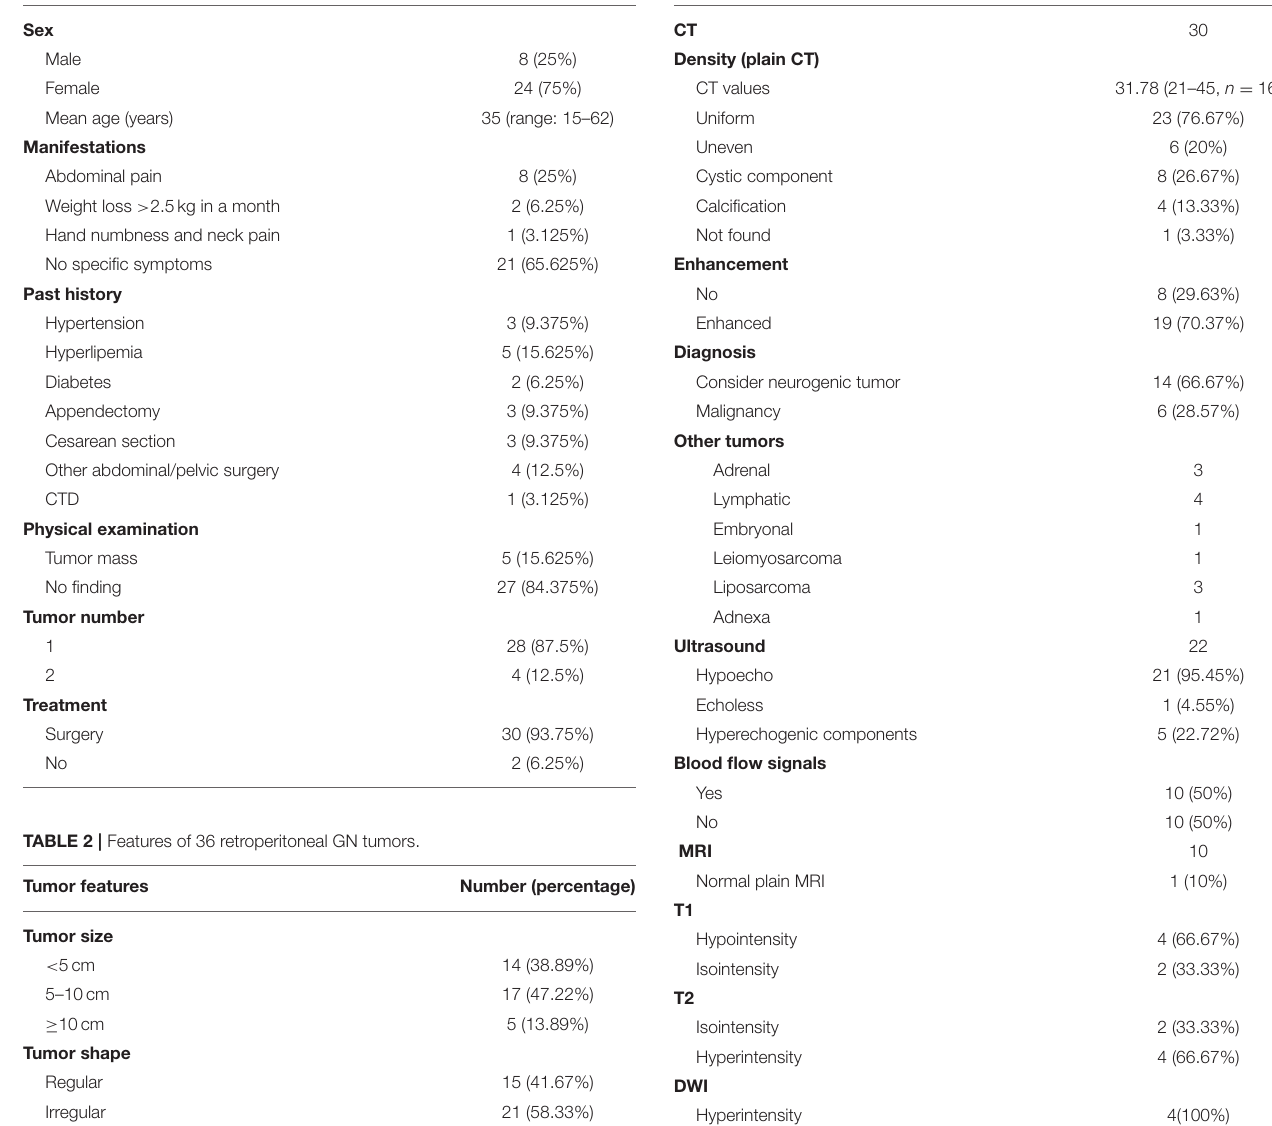
TABLE 1 | Clinical data of 32 retroperitoneal ganglioneuroma cases. Clinical characteristics